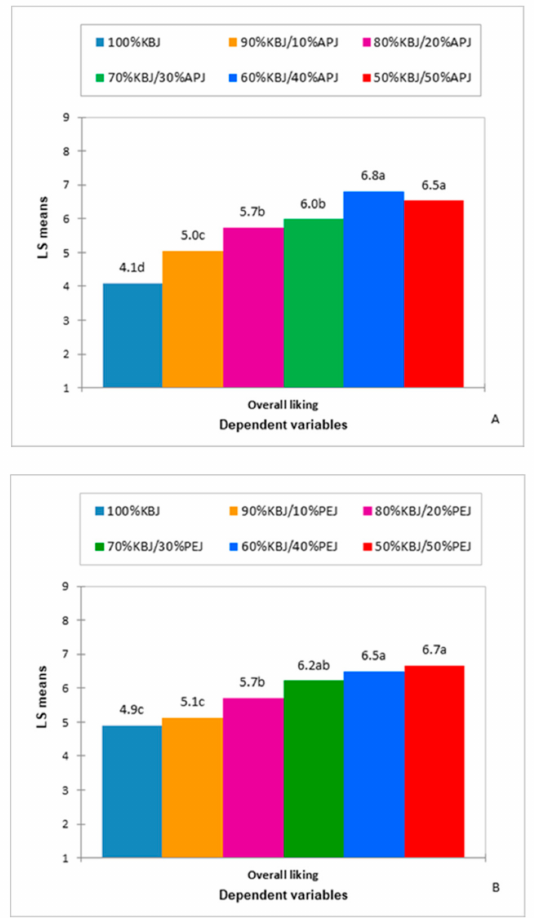
Figure 4. Mean overall liking scores of the kiwiberry juice and kiwiberry/apple juice mixtures ( A ); the kiwiberry juice kiwiberry/pear juice mixtures ( B ). KBJ—Kiwiberry Juice; APJ—Apple Juice; PEJ—Pear Juice; Different letters between juice samples indicate significant differences according to Tukey’s HSD